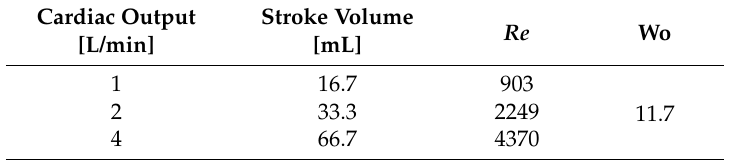
Table 1. Basic hemodynamic and non-dimensional fluid dynamic